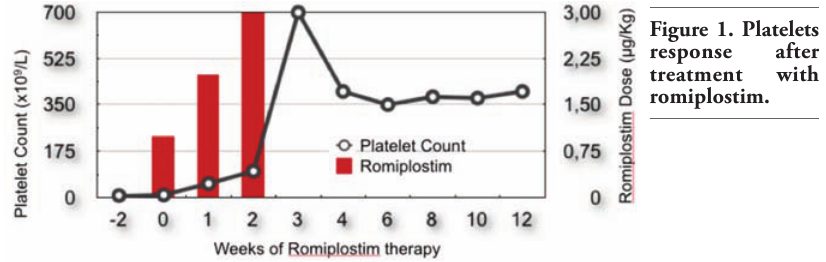
Figure 1. Platelets response after treatment with